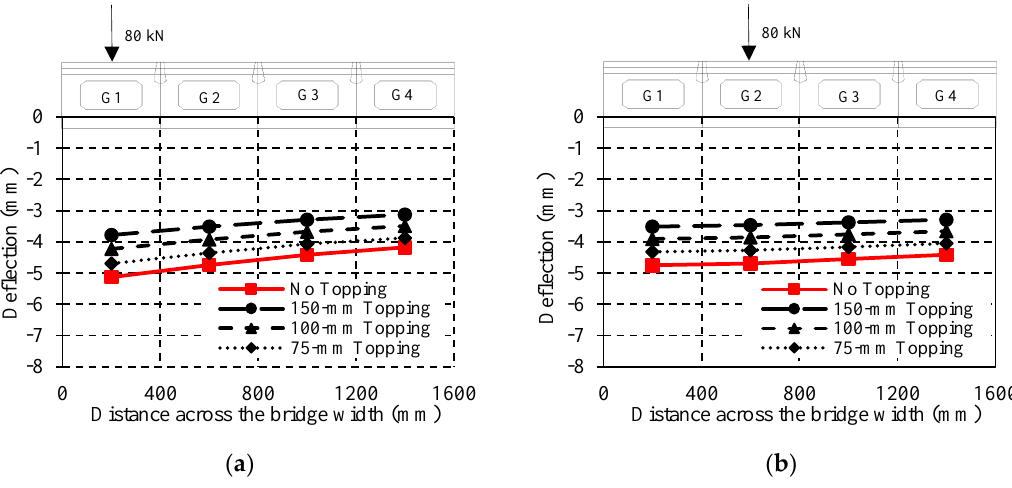
Figure 11. Mid-span deflection profile for different thicknesses of concrete topping: ( a ) external girder G1 loaded and ( b ) interior girder G2 loaded.